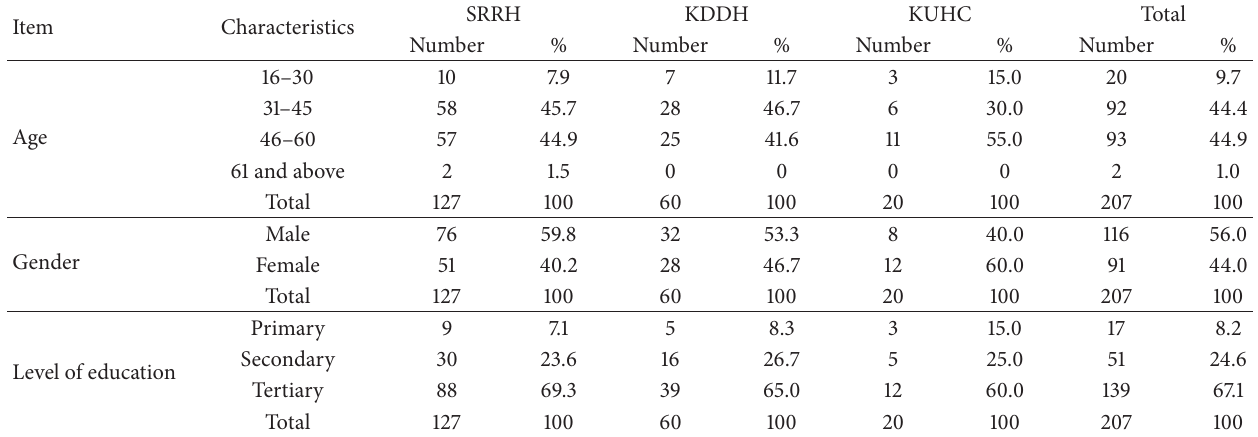
Table 2: Demographic information of employees in the sampled hospitals.